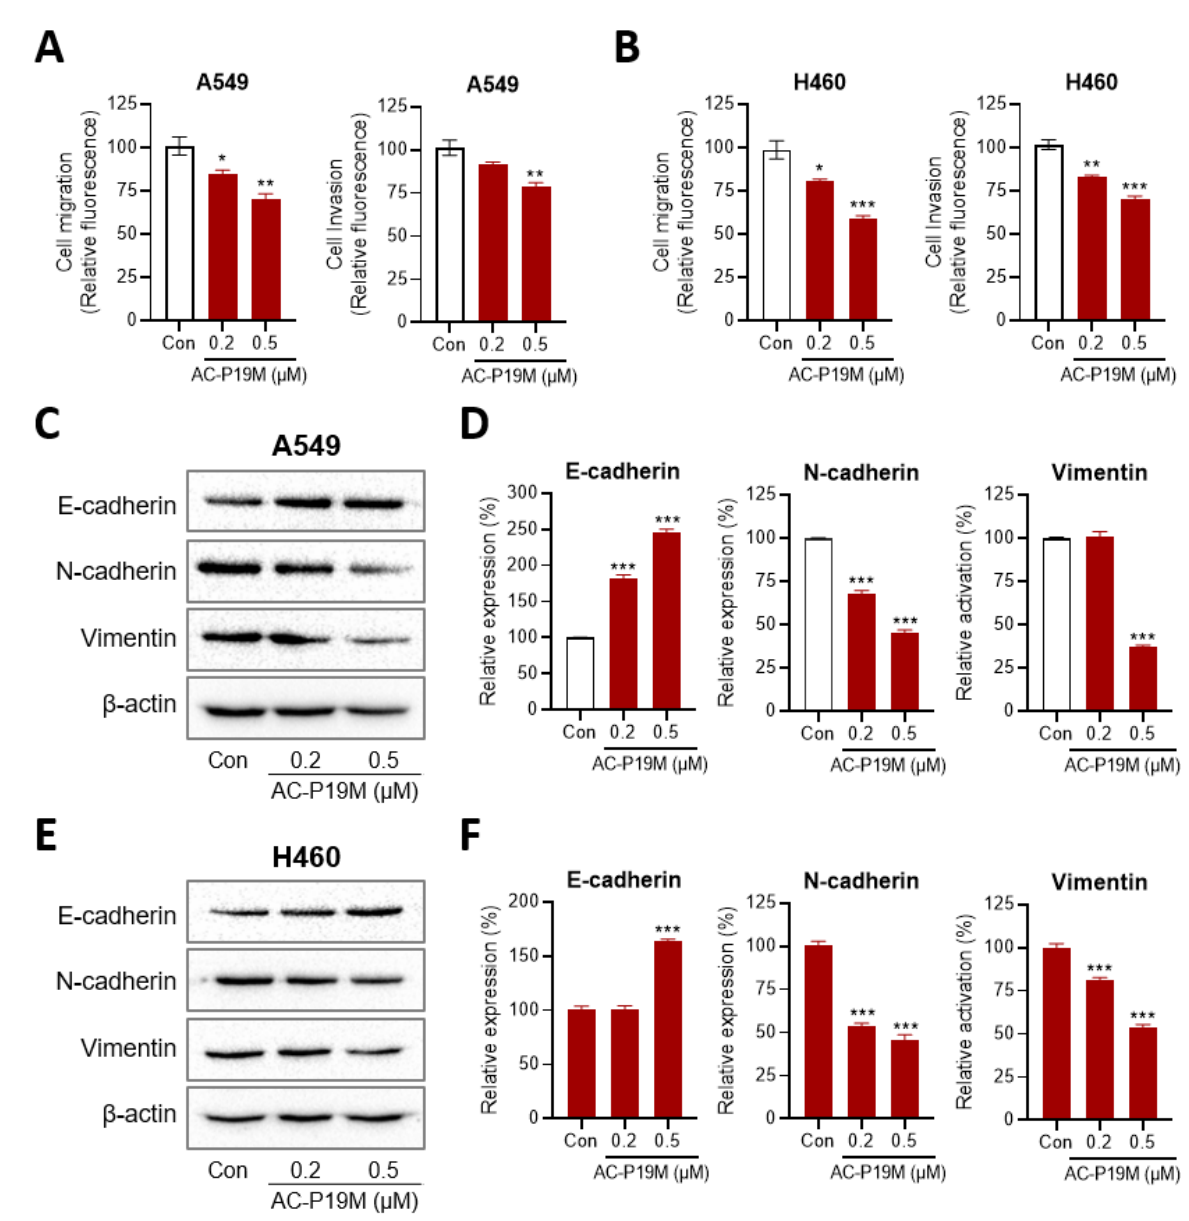
Figure 5. Inhibition of EMT by AC-P19M in lung cancer cells. Lung cancer cells were treated with 0.2 µ M or 0.5 µ M of AC-P19M to perform cell migration and invasion assays. The migratory and invasion activity in both ( A ) A549 and ( B ) H460 cells decreased after peptide treatment. ( C , E ) Western blot analysis showed changes in protein levels of EMT markers upon AC-P19M treatment in ( C , D ) A549 and ( E , F ) H460 cells. The protein levels of the epithelial cell marker, E-cadherin, increased, whereas those of the mesenchymal cell markers, N-cadherin and Vimentin, increased upon peptide treatment in a dose-dependent manner. Data are presented as the mean ± SEM. *, p < 0.05; **, p < 0.01; ***, p < 0.001 compared to the control group.